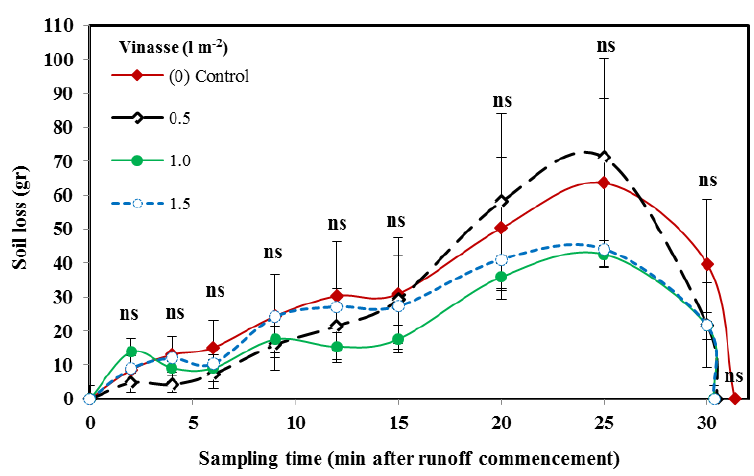
Figure 4. Variations of soil loss per m 2 area under different vinasse treatments under study conditions (rainfall intensity of 72mmh − 1 and experiment duration of 30min); “ns” indicates non significant differences among study treatments ( P > 0.05) for each sampling